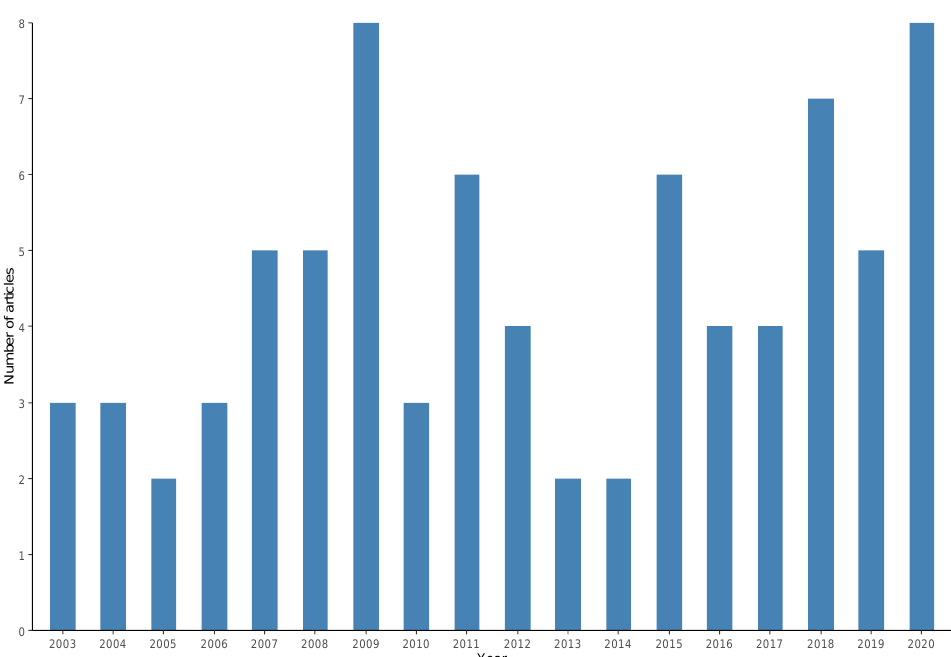
Figure 7. Frequency of scientific articles on microbiological diagnoses of Salmonella spp. in aquacul- ture between 2000 and 2020 by year of publication.